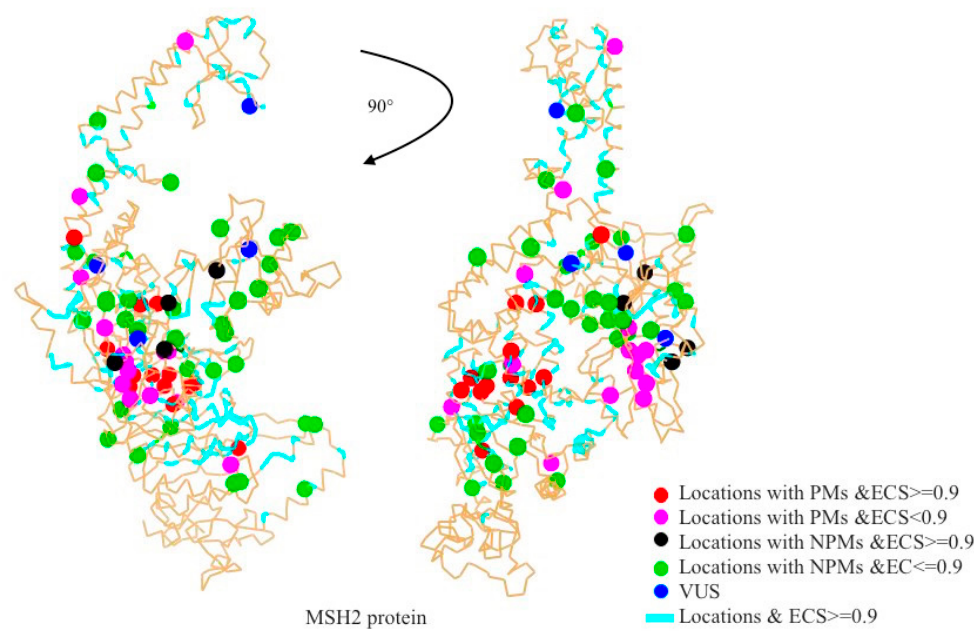
Figure 2. Visualization of highly conserved residues and mutations mapping onto the MSH2 protein structure. PMs: Pathogenic mutations, NPMs: Non-pathogenic mutations, VUS: Variants of unknown significance, and ECS: Evolutionary conservation score.